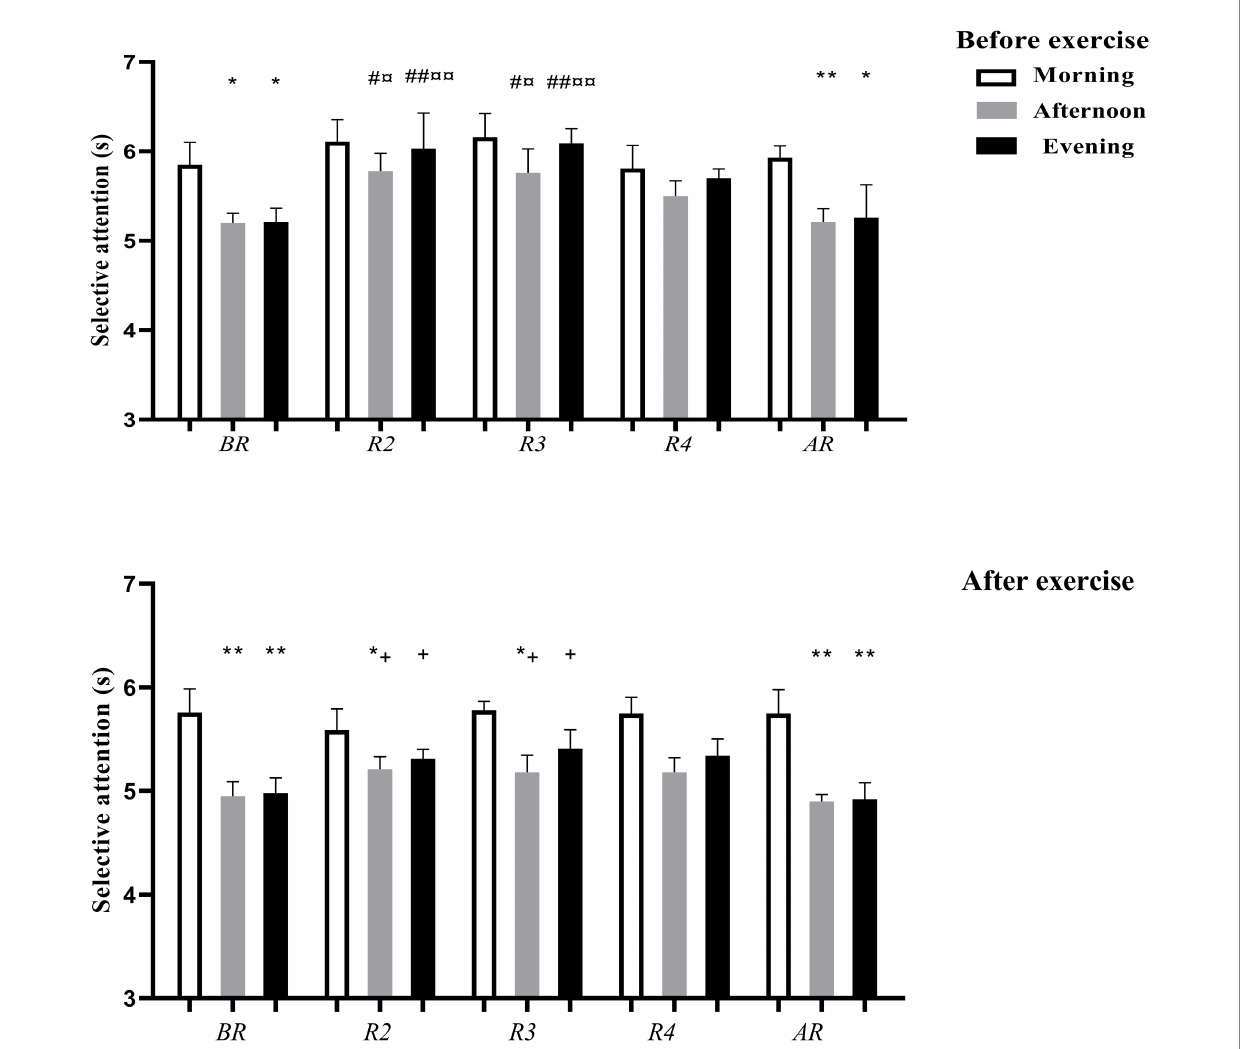
FIGURE 2 Selective attention (mean ± SD) measured before and after exercise in the morning, afternoon and evening 1 week before Ramadan (BR), the 2nd week of Ramadan (R2), the 3rd week of Ramadan (R3), the 4th week of Ramadan (R4) and 2 weeks after Ramadan (AR), *, **, ***: significant difference in comparison with the morning at p < 0.05, p < 0.01, p < 0.001, respectively; #, ##, ###: significant difference in comparison with before Ramadan at p < 0.05, p < 0.01, p < 0.001, respectively; ¤ , ¤¤ , ¤¤¤ : significant difference in comparison with after Ramadan at p < 0.05, p < 0.01, p < 0.001, respectively; +, ++, +++: significant effects of exercise at p < 0.05, p < 0.01, p < 0.001,